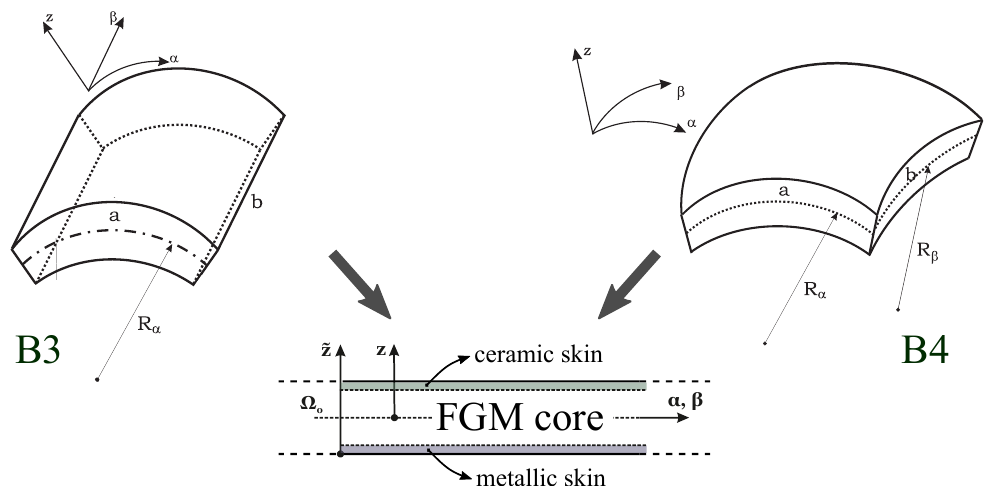
Figure 2. Geometrical data and coordinate system for cylindrical and spherical shell panels. The figure also shows the stacking sequence used in Benchmarks 3 and